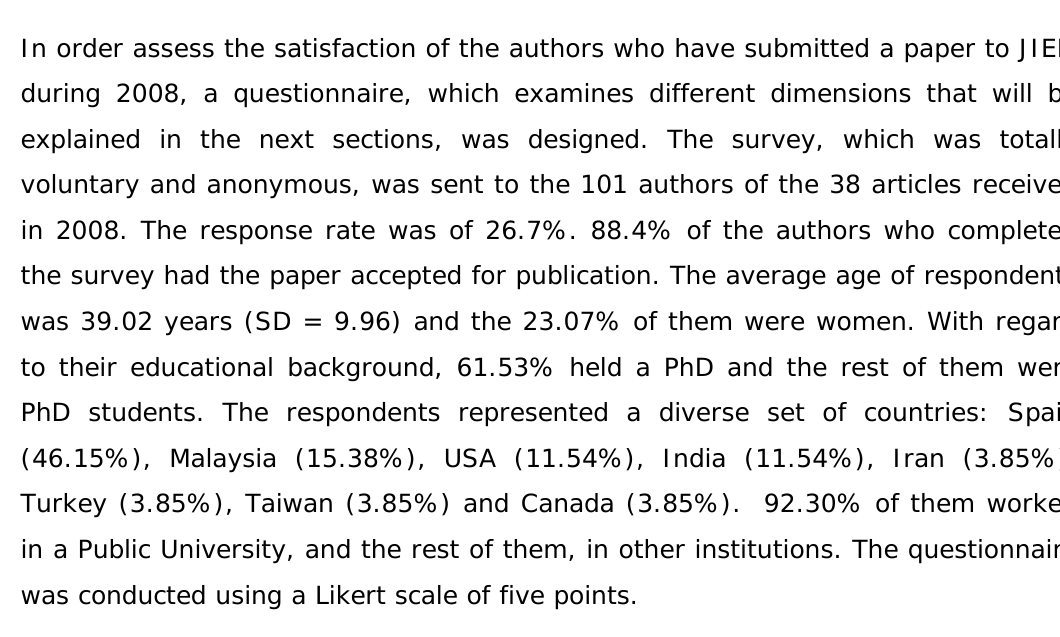
Figure 2. “Nationalities of the authors who published in JIEM during